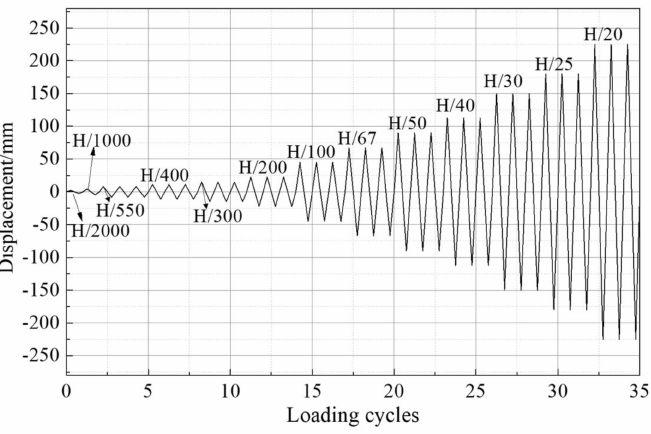
Figure 4. Loading